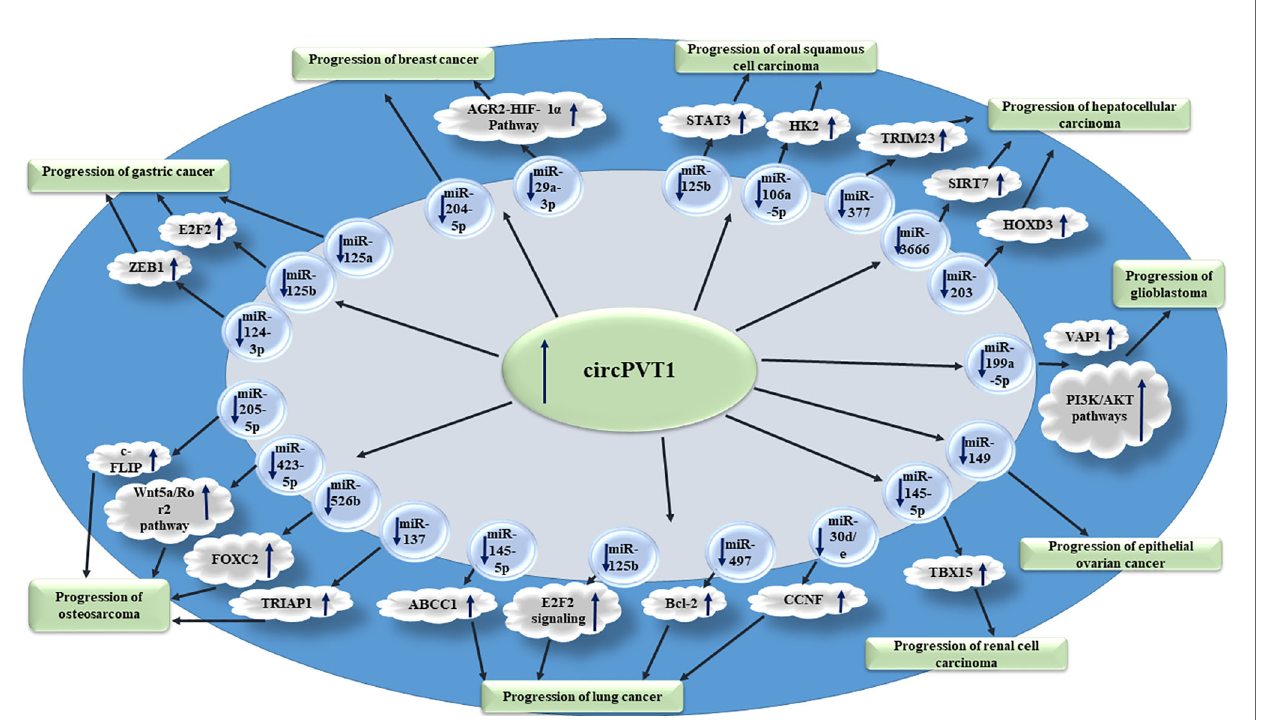
FIGURE 1 | Oncogenic roles of circPVT1 in different cancer types are mainly exerted through sponging